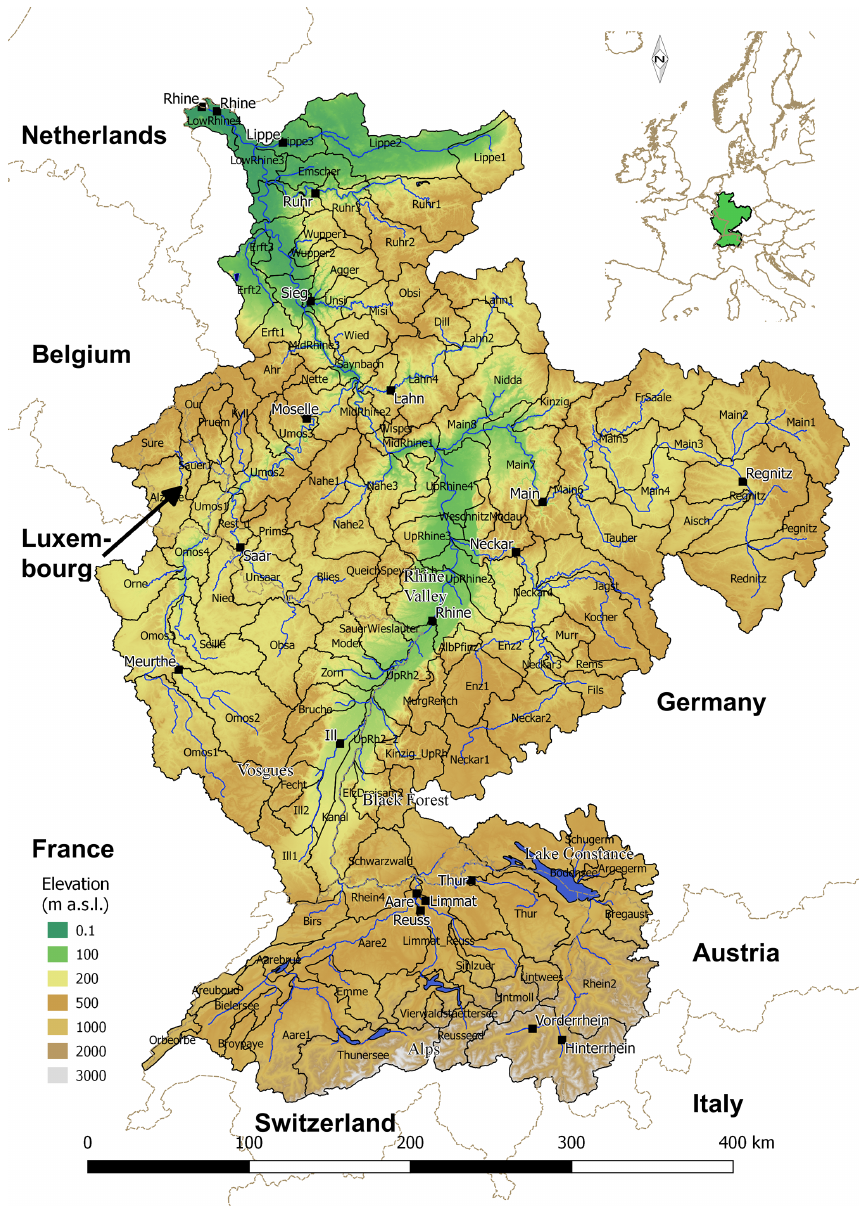
Figure 1. Map of the Rhine basin, Europe. Black lines delineate 148 subbasins used in the analysis of the meteorological forecast skill. Square markers show the locations used for forecast skill